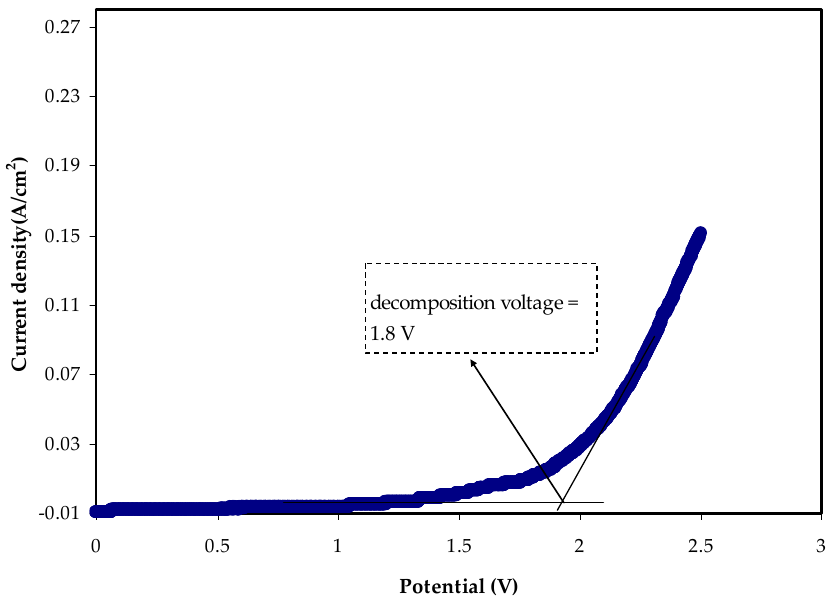
Figure 10. Current versus potential for the highest conducting (MCKI4) sample.